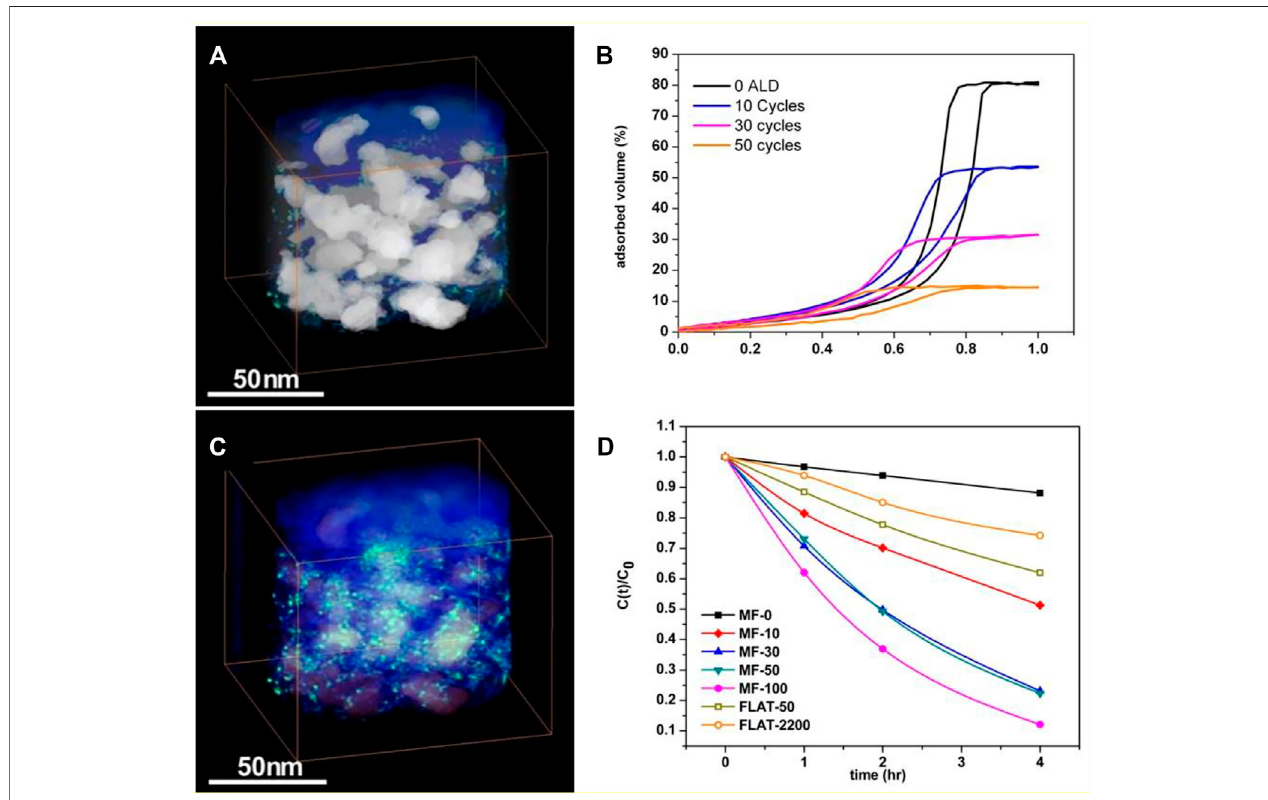
FIGURE 13 | Electron tomography reconstructions of the atomic layer deposition (ALD) deposited TiO 2 (50 cycles) containing mesoporous silica fi lm made of nanoslabs having 80% porosity (A,C) : 3D voltex visualization of the reconstruction of a part of the fi lm; mesopores highlighted in white in (A) , and anatase particles in green in (C) . Toluene adsorption isotherms (B) determined using EP on different pieces of the same fi lm after the indicated ALD treatments. (D) Photocatalytic degradationofmethyleneblueontheTiO